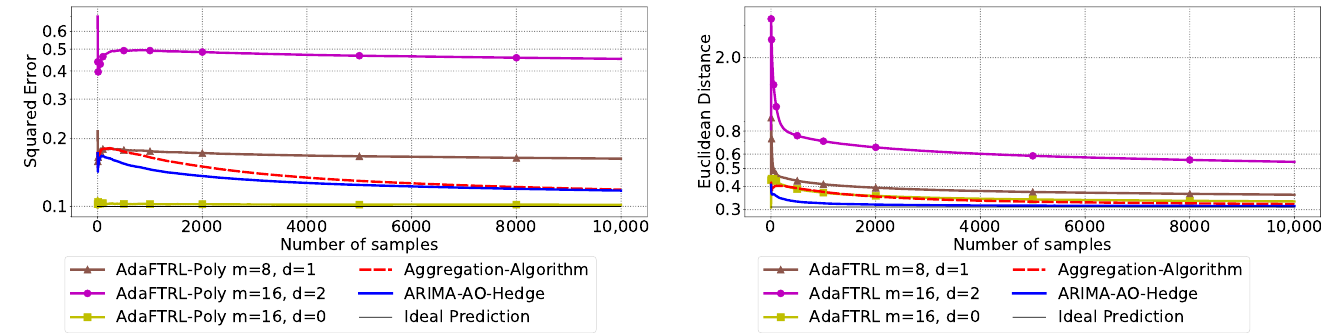
Figure 8. Model selection in setting 2.